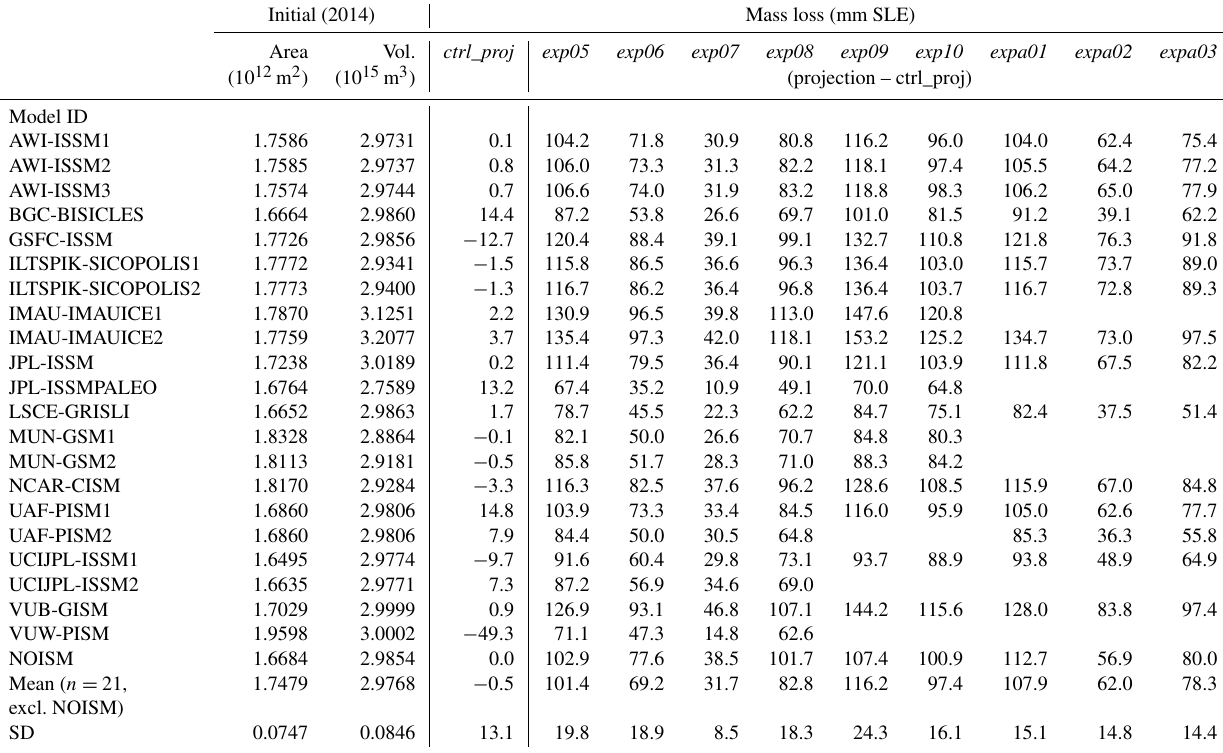
Table B1. Modelled present-day ice sheet area, ice volume and mass change in future experiments for all participating models.